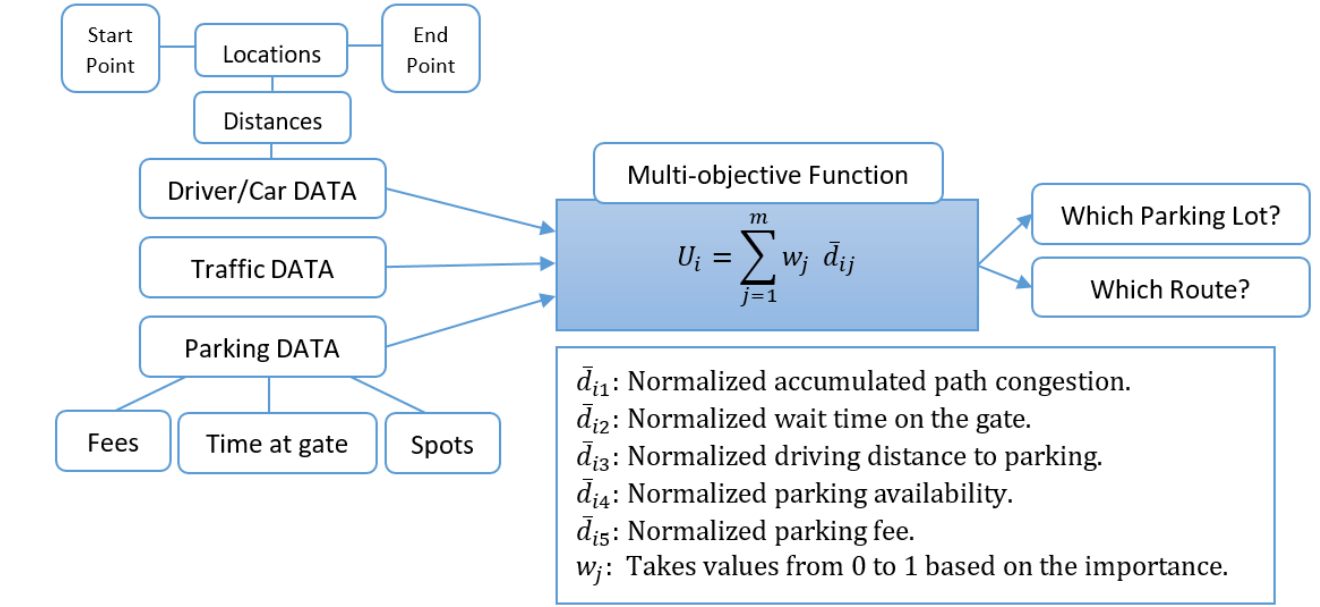
Figure 3. Description of the multi-objective